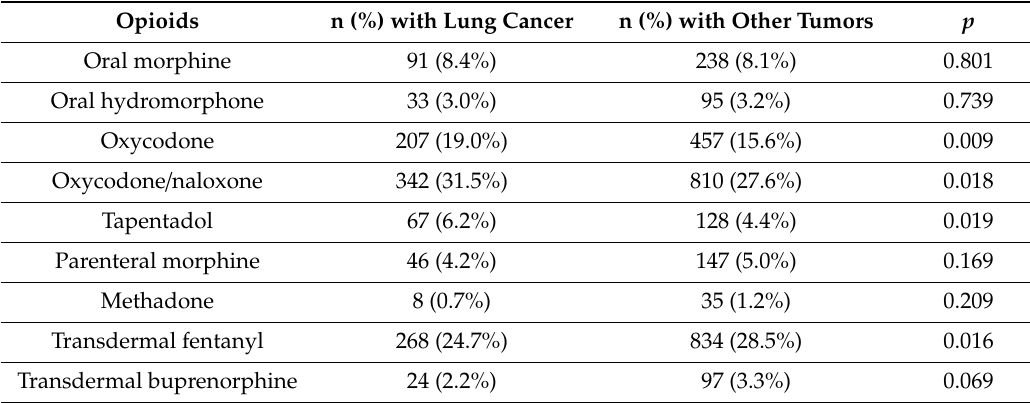
Table 2. Opioids used for background pain in patients with and without lung cancer.